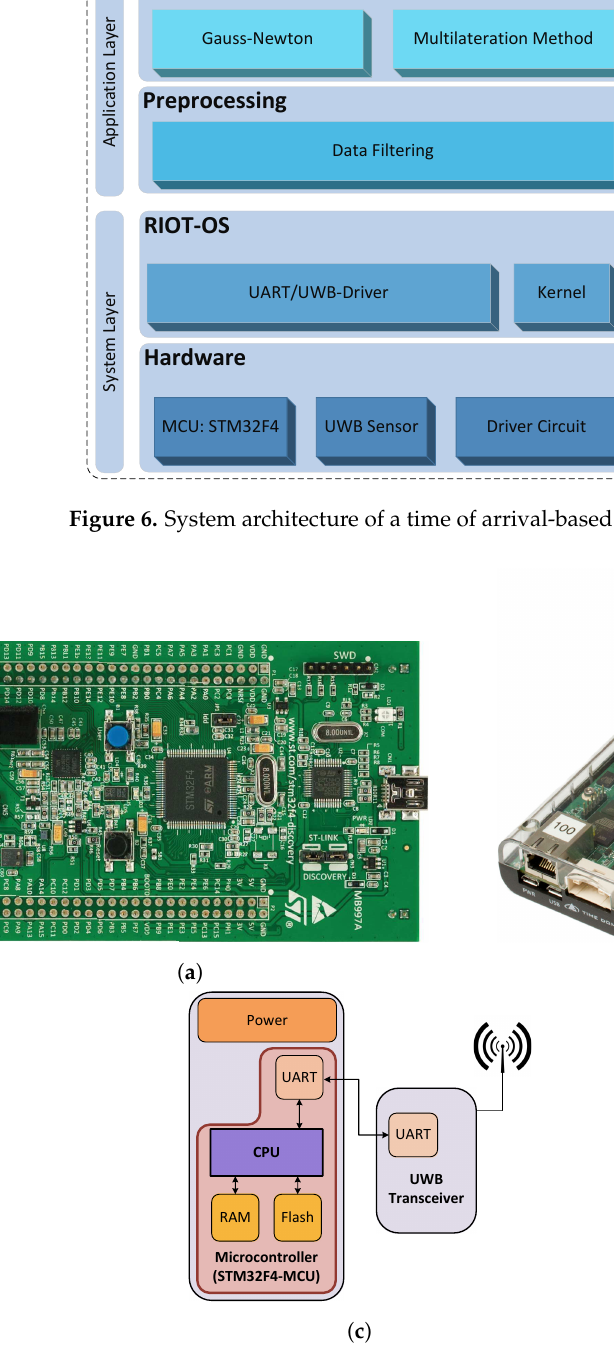
Figure 7. UWB-based localization system hardware. ( a ) STM32F407 Discovery Board [58], ( b ) UWB P440 transceiver [59], ( c ) simplified hardware block diagram. Table 2. The properties of the STM32F407 MCU. MCU, Microcontroller Unit